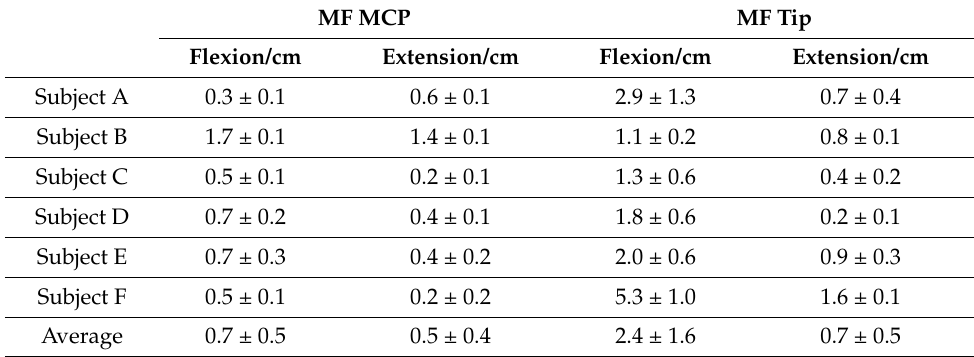
Table 2. The RMSD values between the P0 and P2 for each of the